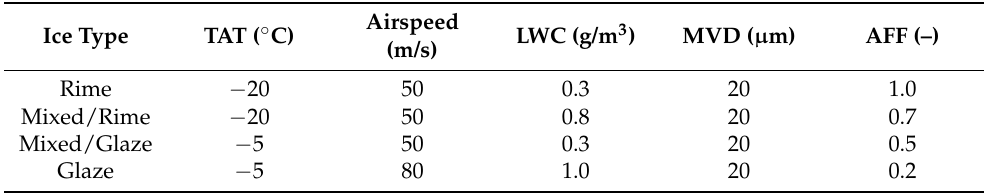
Table A1. Icing conditions of total air temperature (TAT), airspeed, liquid water content (LWC), mean effective volume droplet diameter (MVD), and an approximate freezing fraction (AFF) used